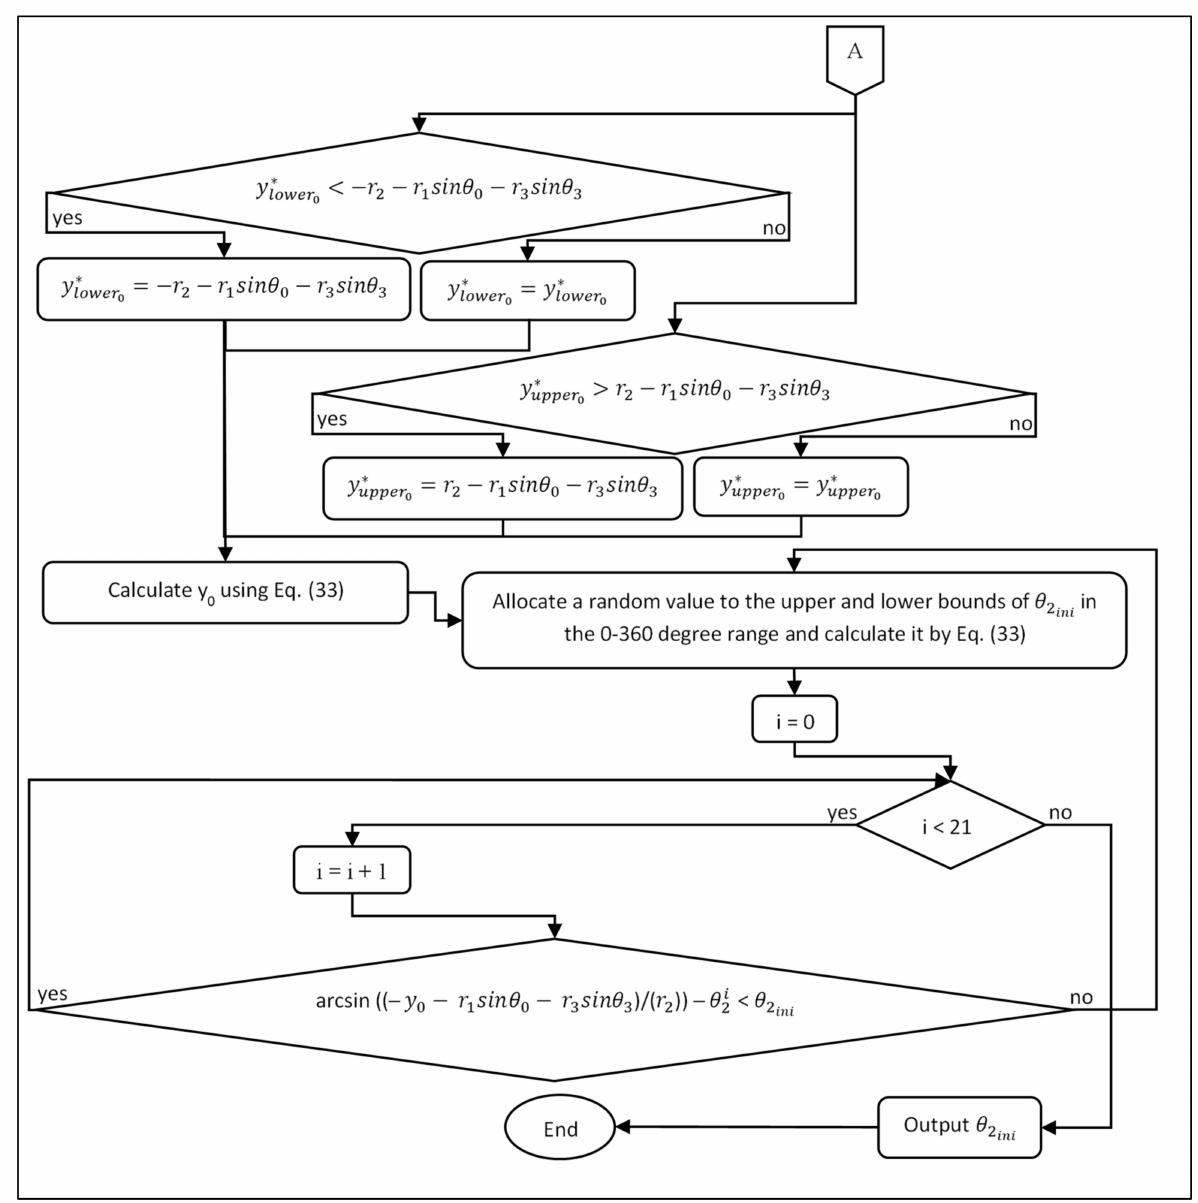
Figure 6. Flowchart of sequential transformation set for the four-bar cultivator